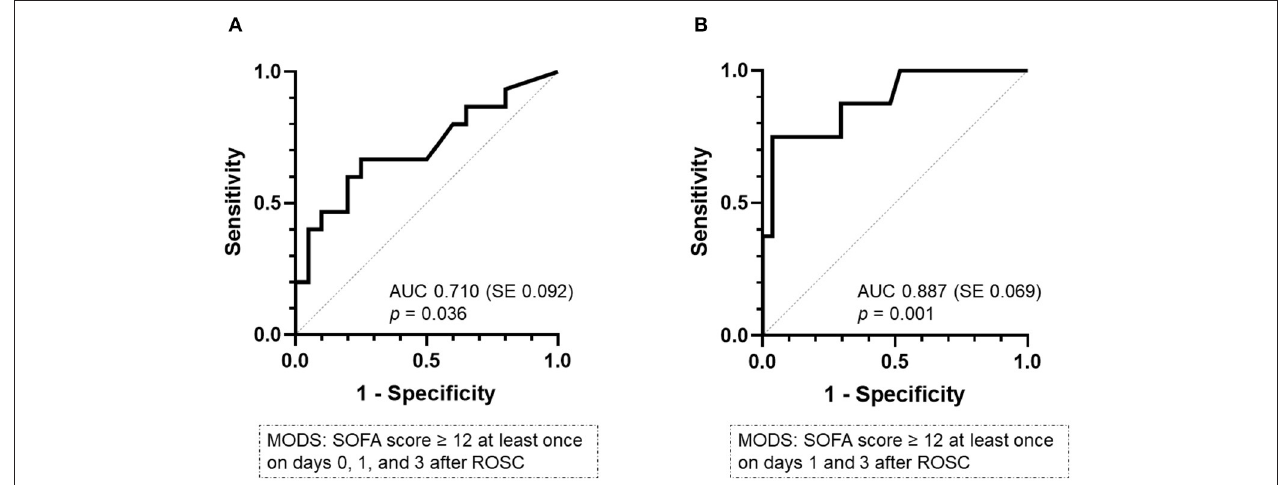
FIGURE 3 | Receiver-operating characteristics curve analysis of the plasma level of histones at 0h on predicting MODS. (A) MODS was defined as a SOFA score of ≥ 12 at least once on days 0, 1, and 3 after ROSC. (B) MODS was defined as a score of ≥ 12 at least once on days 1 and 3 after ROSC. AUC, area under the curve; MODS, multiple organ dysfunction syndrome; ROSC, return of spontaneous circulation; SE, standard